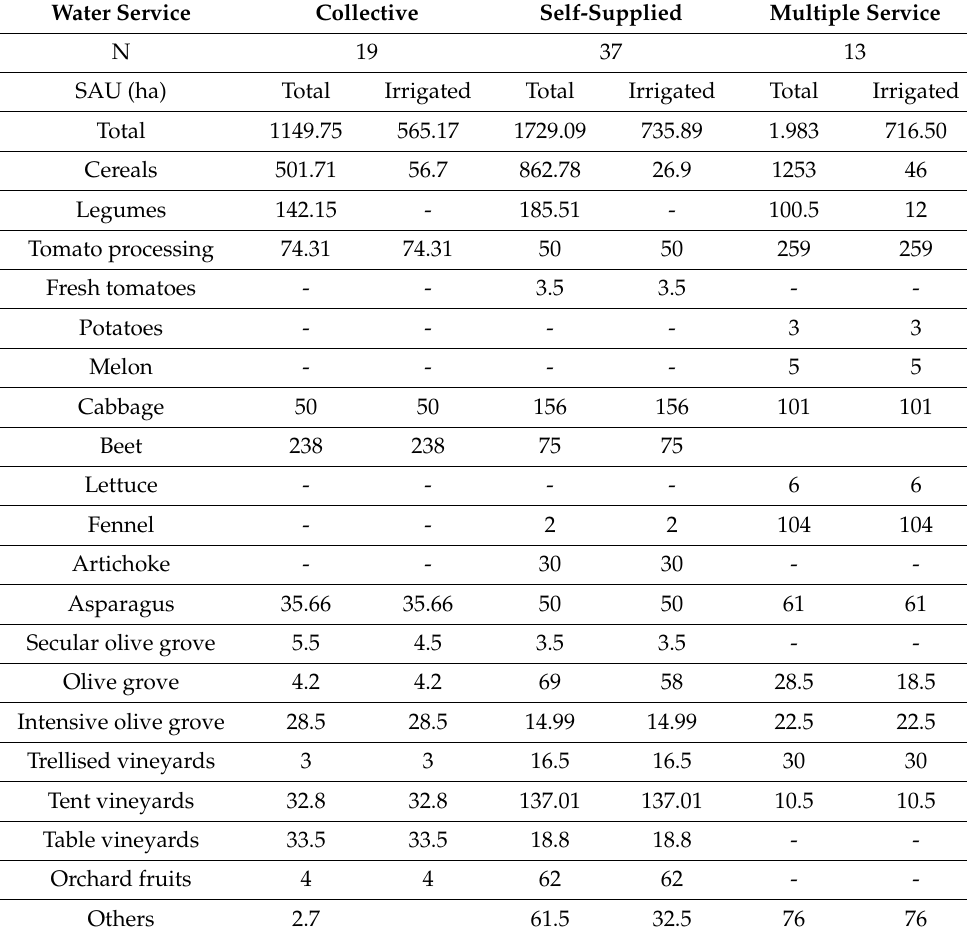
Table 3. Crop pattern by water service.